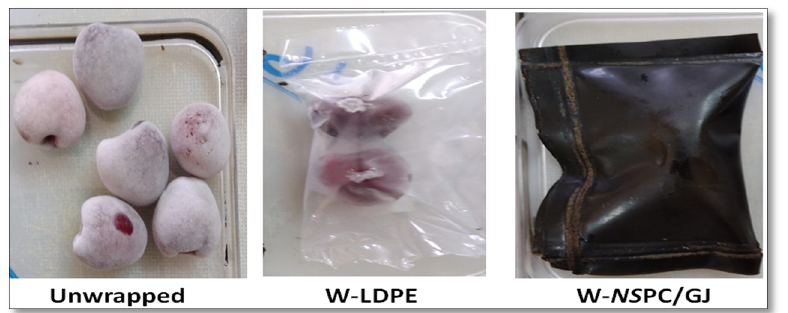
Figure 5. Sweet cherries image after removing from freezer: unwrapped (control) and wrapped (W) with LDPE or NS PC with 6% GJ.